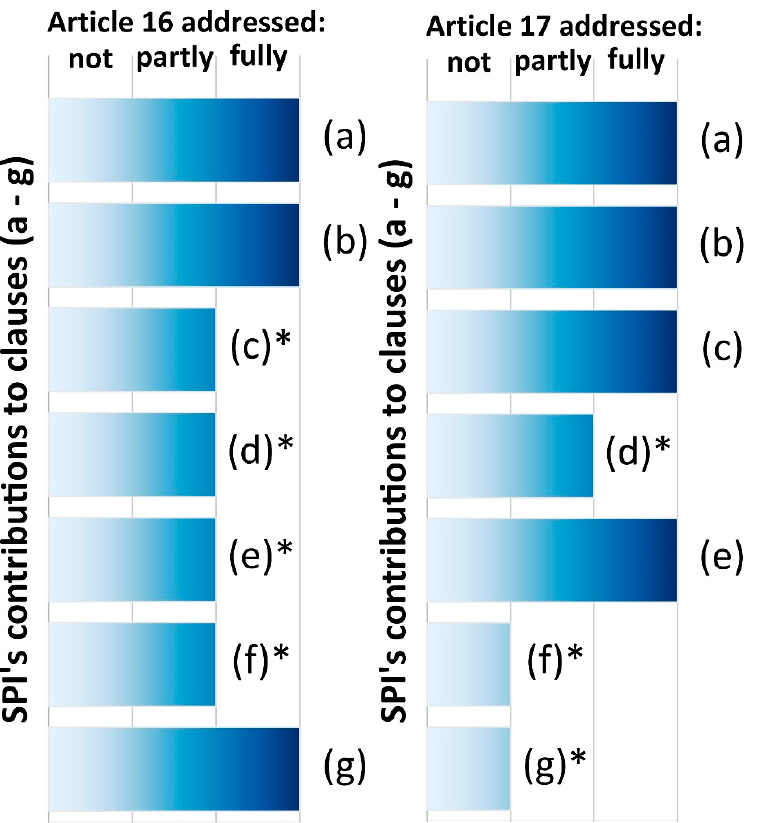
Figure 6. The scientific and technical impact of SPI on the various clauses ( a – g ) under Article 16 “Scientific and Technical Cooperation” and Article 17 “Research and Development” has been categorized to show a trend from not addressed at all, to partially addressed, to fully addressed. The smooth color progression to darker shades highlights the trend in the impact of SPI’s work for each clause. The asterisk after some clauses indicates that in Table S8 we provide a rationale for certain limitations of SPI’s impact and how they might be effectively addressed.